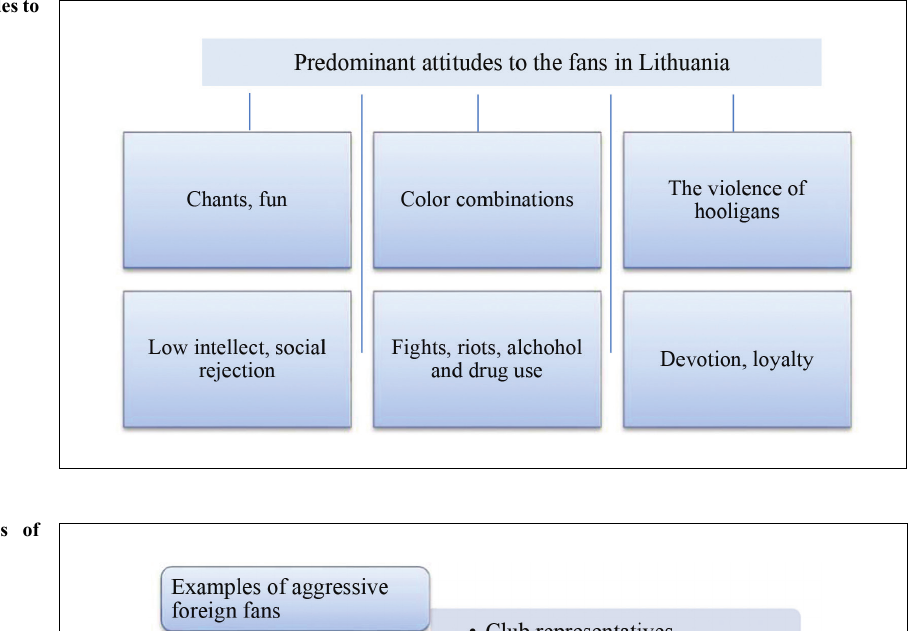
Figure 7. Fan aggression preven